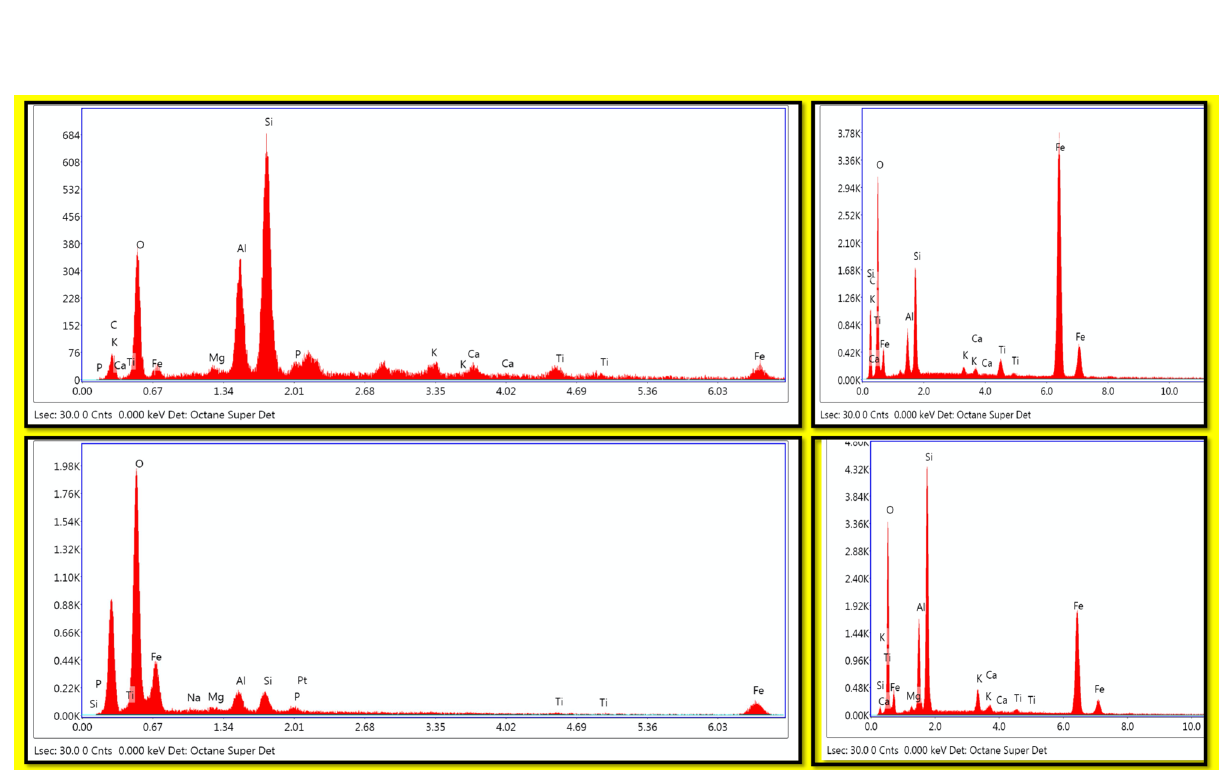
Figure 15. Energy Dispersive X-Ray Spectroscopy (EDS) of exemplary Fe and Si-rich microspherules from the Turner earthworks and village site, Hamilton County, Ohio. Kenneth Barnett Tankersley used Microsoft PowerPoint for Mac Version 16.41 (www. micro soft. com) to create this